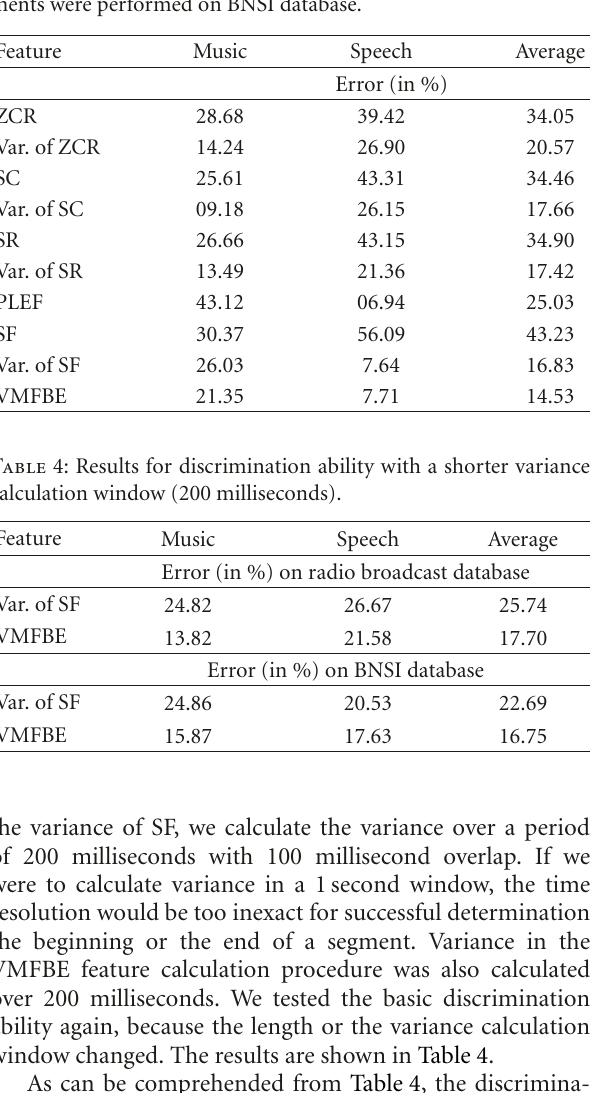
Table 3: Speech/Music discrimination ability of features. Experi- ments were performed on BNSI database.